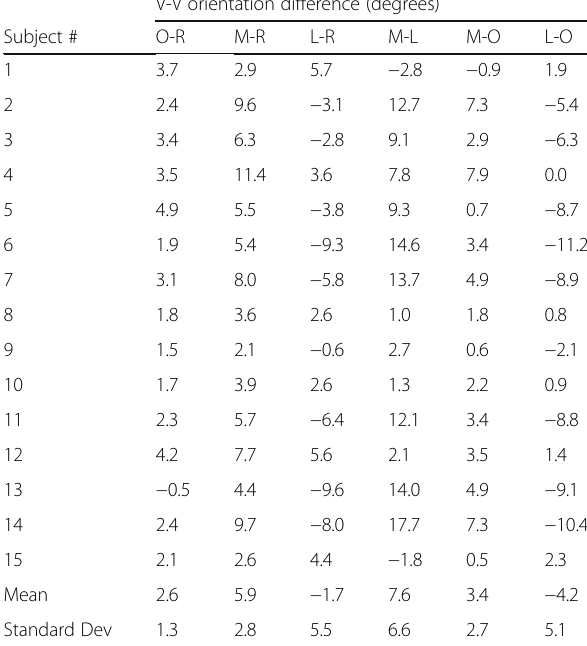
Table 5 Difference in V-V orientation between each pair of calculated planes for 15 patients